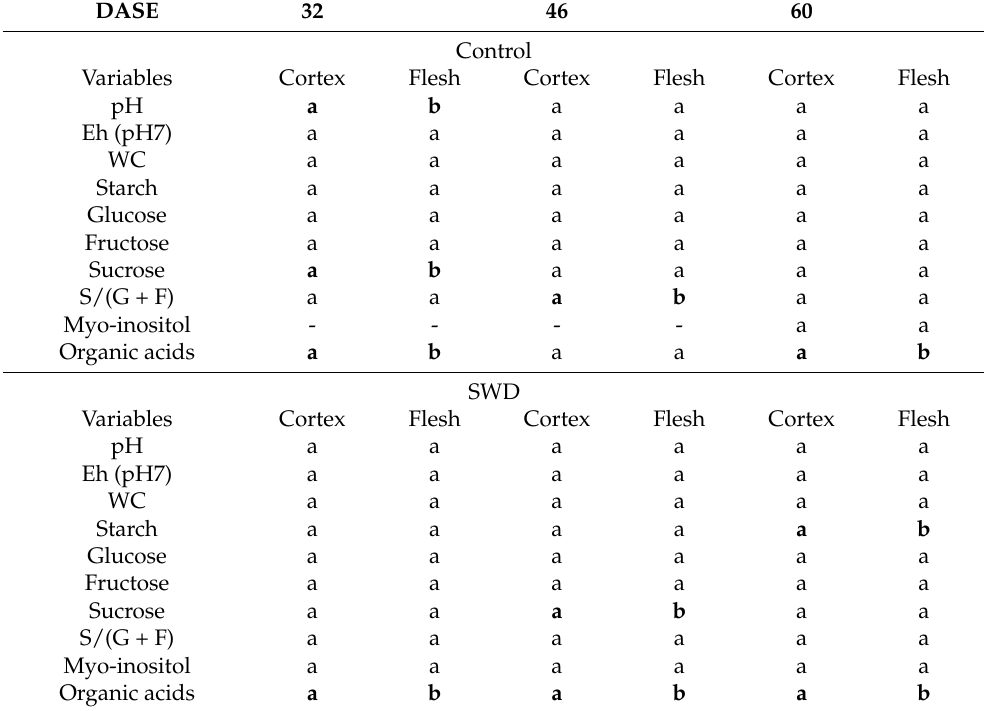
Table 2 . Statistical evaluation of the effect of water regime on biochemical parameters (Student t- test or Mann–Whitney test; Statgraphics, alpha = 5%). Different letters between Control and SWD conditions for the same DASE indicate a statistically significant difference.